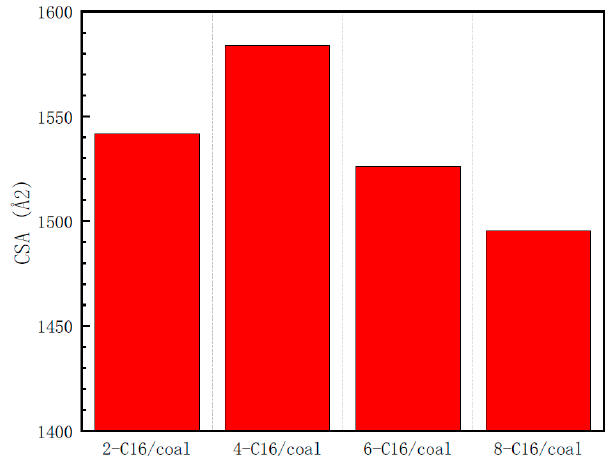
Figure 5. The contact surface areas of different models.